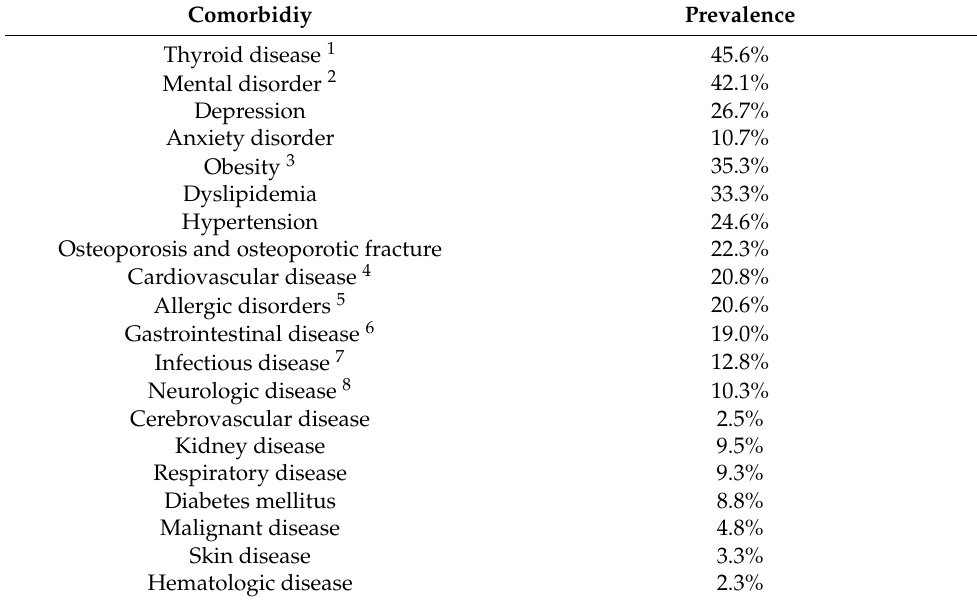
Table 2. Prevalence of comorbid diseases in SLE patients at the community-based registry in Crete ( n =